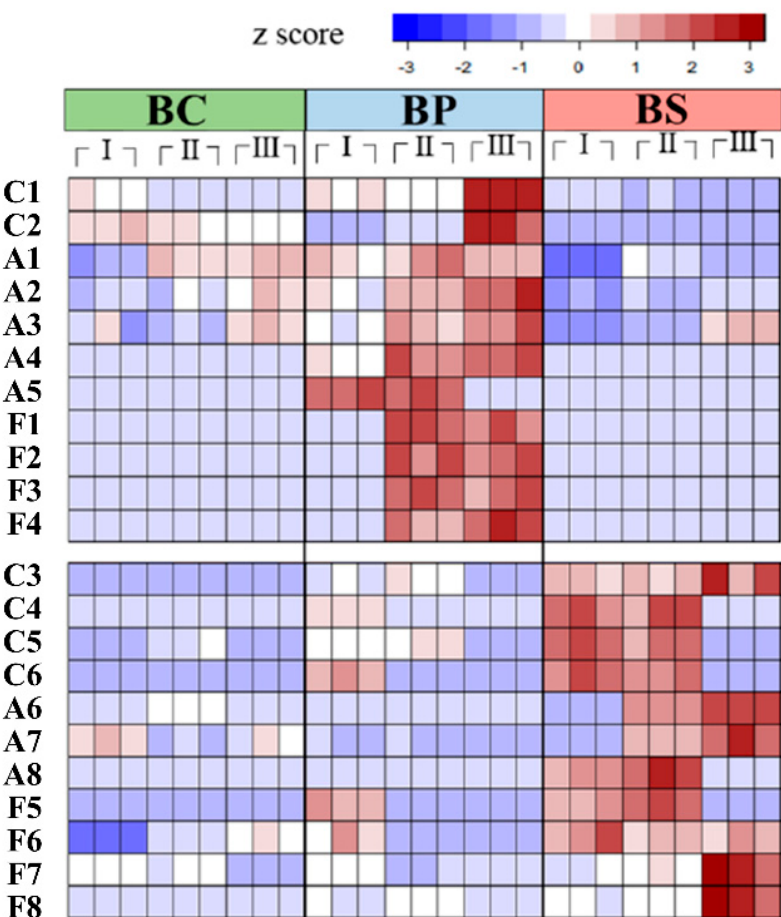
Figure 2. The heatmap shows the z-score value of each metabolite selected by VIP score and pcorr values (VIP > 1 and IpcorrI > 0.5) of the OPLS-DA model, and color intensity represents the metabolic expressions: red represents the up-expression and blue the down-expression. Main metabolism was divided into three parts: C: carbohydrate metabolism, A: amino acid metabolism, and F: fatty acid metabolism. Abbreviations are as follows: BC: control sample, BP: cultivation under alkaline